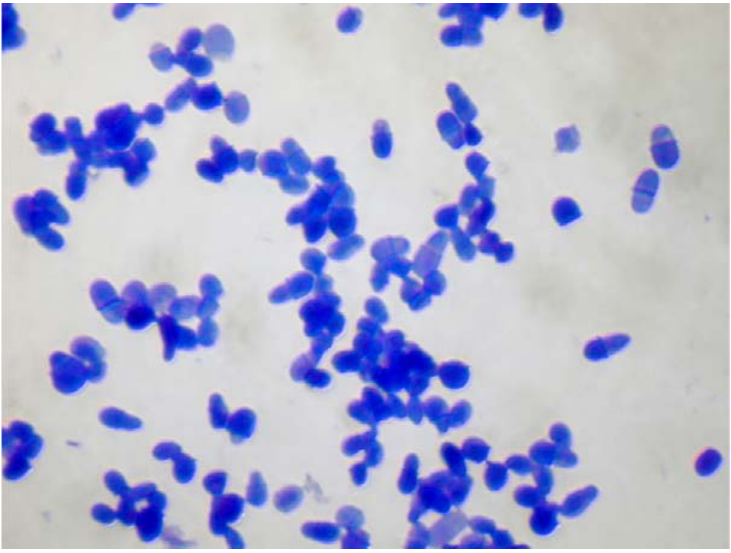
Figure 1. Microscopic image of a Malassezia spp. culture. Methylene blue